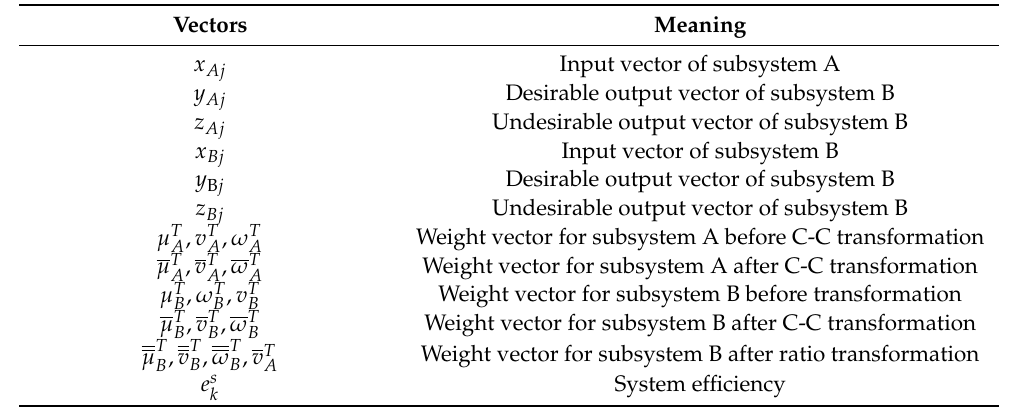
Table A1. The vector notations used in Section